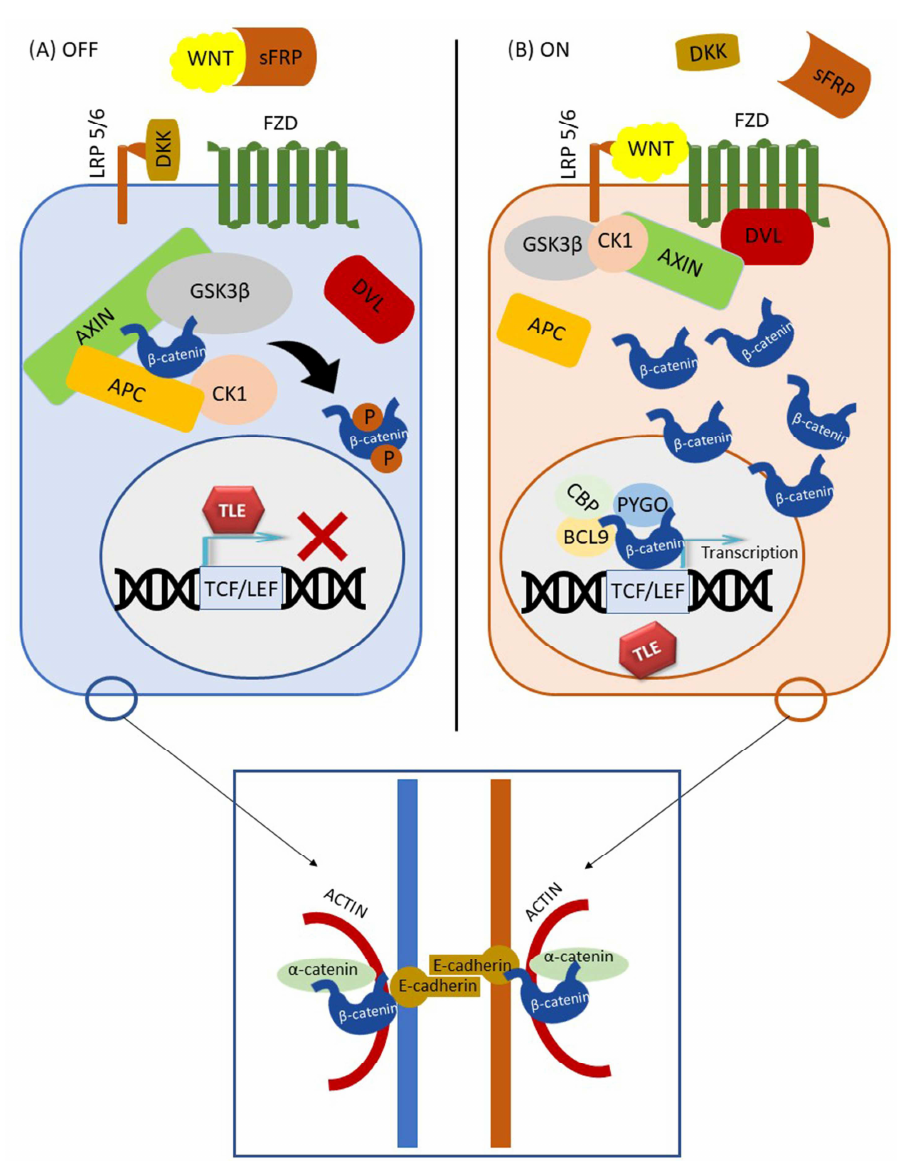
Figure 1. Canonical Wnt signaling pathway. Two modes of signaling are shown: ( A ) inactive and ( B ) active. Adherens junction is shown in the blue square.